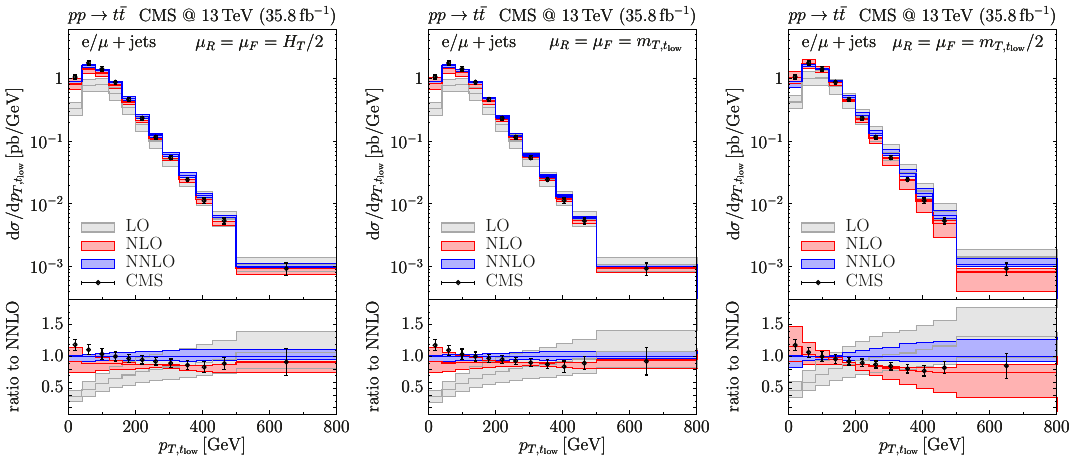
. CMS data [9] and LO, NLO high (central) and m T;t = 2 (right). high high